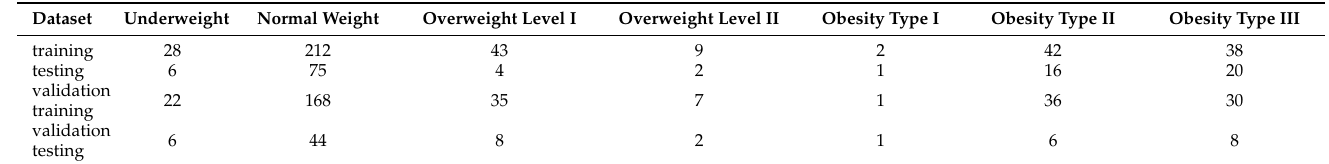
Table 2. The number of observations for obesity level categories in training, testing, and validation